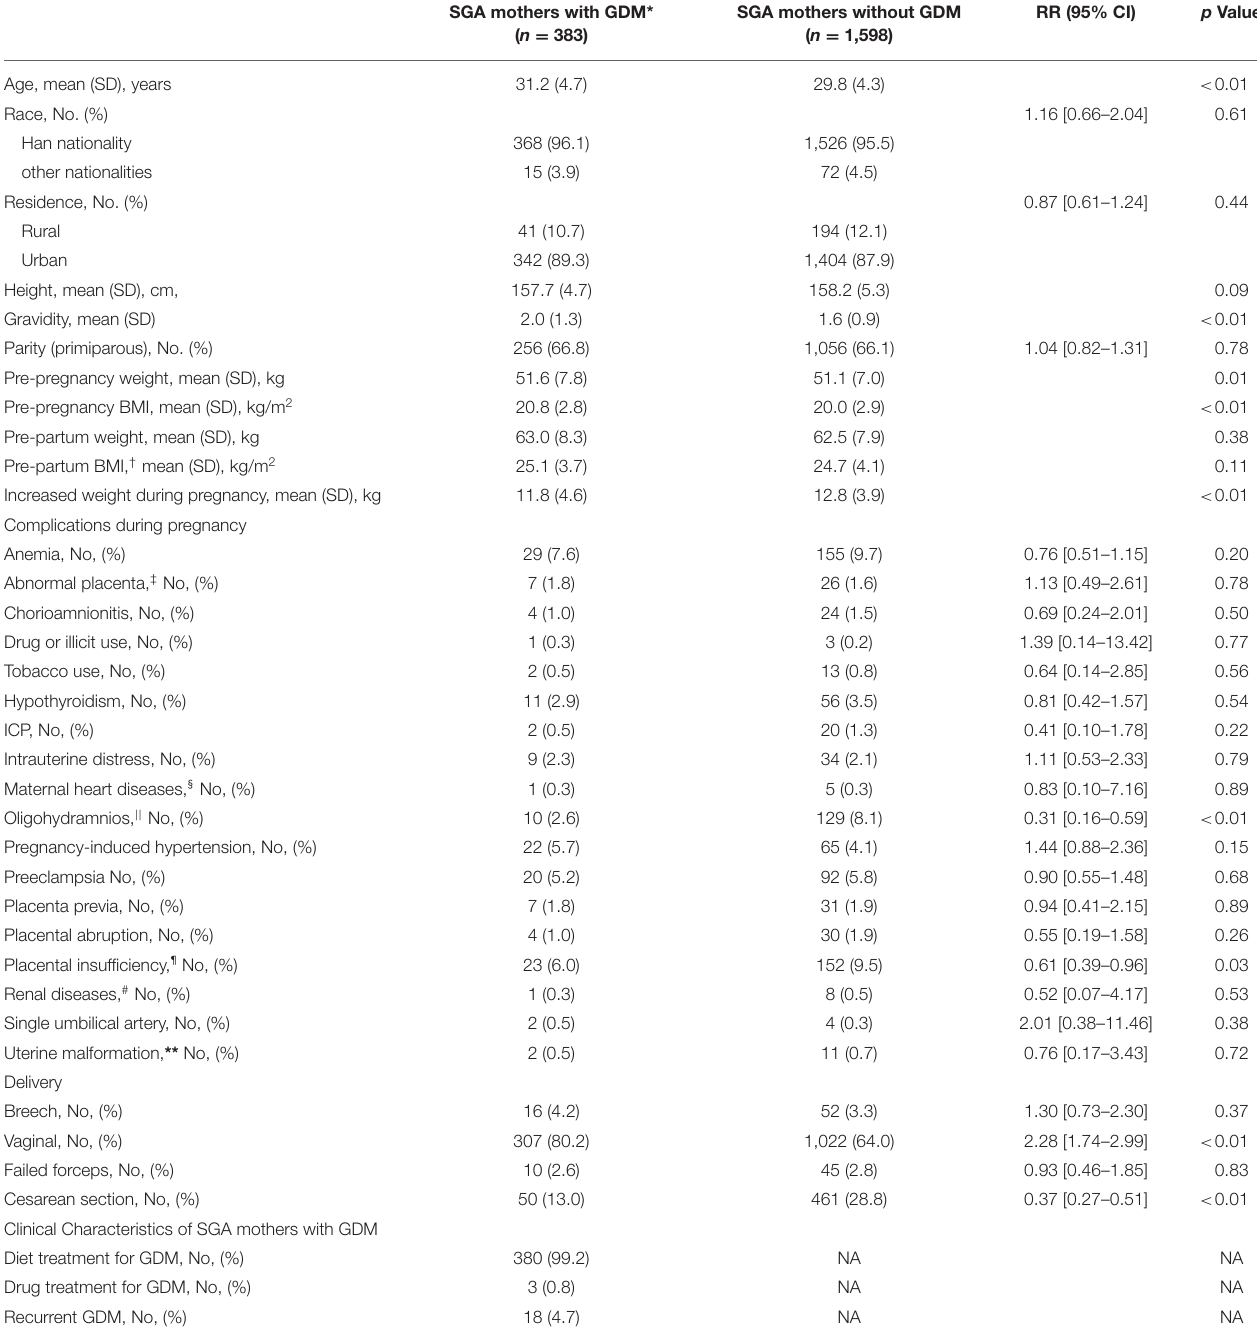
TABLE 1 | Maternal characteristics of women with and without gestational diabetes mellitus ( N =